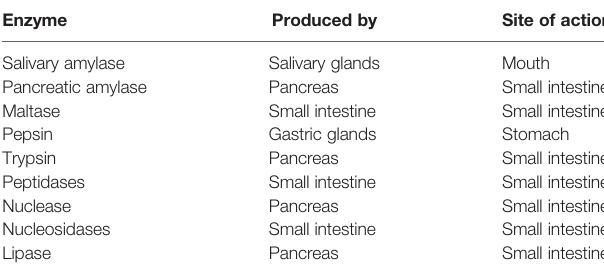
TABLE 1 | Main enzymes in the gastrointestinal tract.